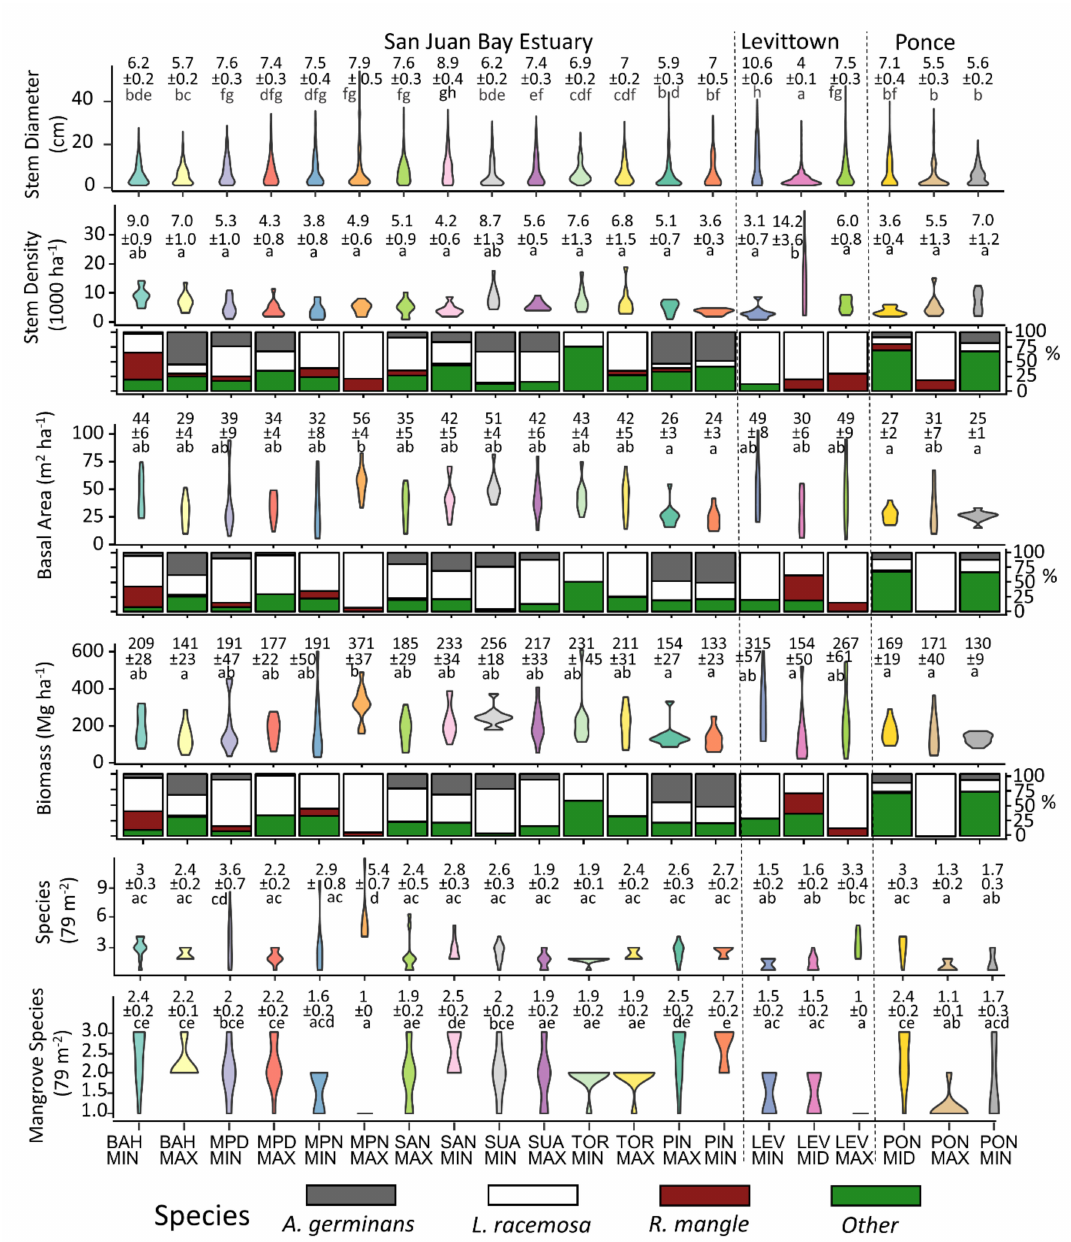
Figure 2. Forest structure and composition based on ground measurements. Violins are colored by site, while bar plot colors indicate species and show the relative proportion of each to the above violin plot. Most sites are dominated by L. racemosa, which was the only mangrove species in some of the most urban sites. Annotations are means and standard errors, and di ff erent letters denote statistical di ff